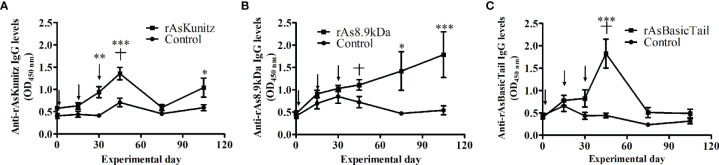
Profile of specific serum IgG levels in mice vaccinated with rAsKunitz (A), rAs8.9kDa (B), and rAsBasicTail (C). Serum IgG levels against each of the recombinant were accessed by ELISA. Arrows indicate the three injections used for immunization and the cross indicates the challenge with ticks. Statistical analysis between control and vaccinated groups: Two-way ANOVA–Bonferroni, *p < 0.05; **P < 0.01; ***p < 0.001.